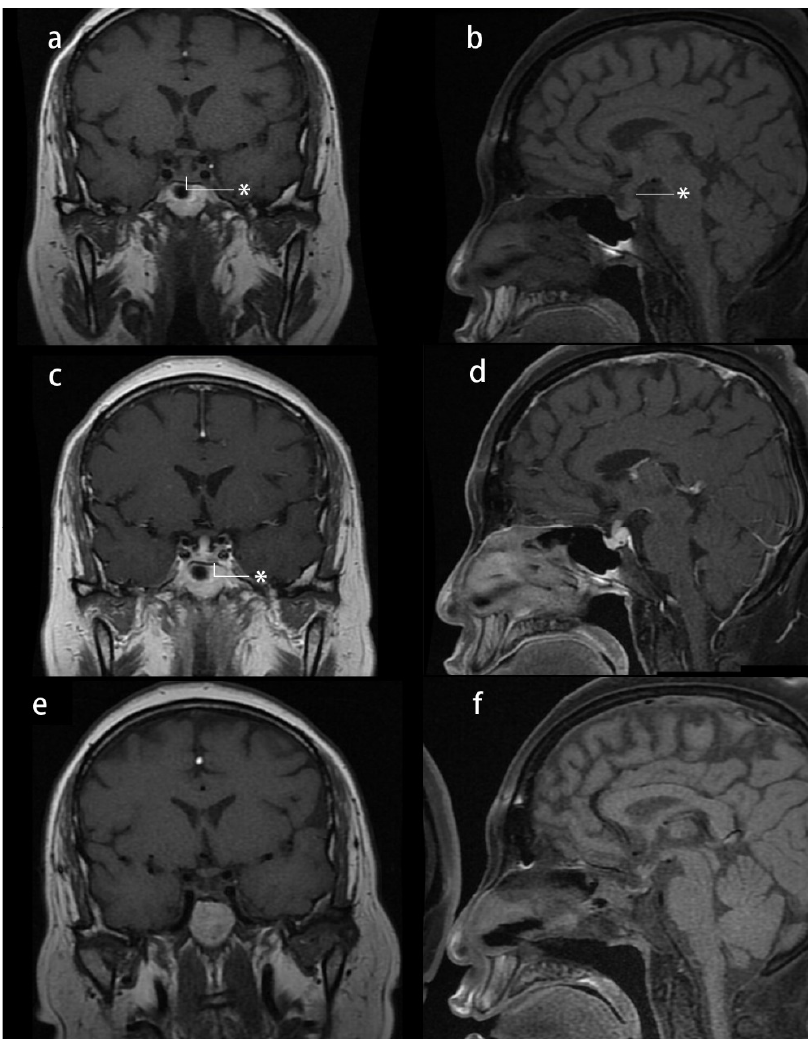
Figure 1. Presurgical and postsurgical pituitary MRI study of case 1: ( a – d ) presurgical MRI study: ( a ) T1-weighted image (T1-WI) coronal plane reveals a thickened pituitary stalk *; ( b ) T1-WI sagittal plane reveals a thickened pituitary stalk and loss of hyperintensity * of the T1 signal in the posterior pituitary gland; ( c ) T1-WI contrast-enhanced coronal plane reveals a hypointense nodule * in the left side of the pituitary gland; and ( d ) T1-WI contrast-enhanced sagittal plane reveals a thickened pituitary stalk; ( e , f ) one-year postsurgical MRI study: T1-WIs showing a thinner pituitary stalk and loss of hyperintensity of the T1 signal in the posterior pituitary gland.